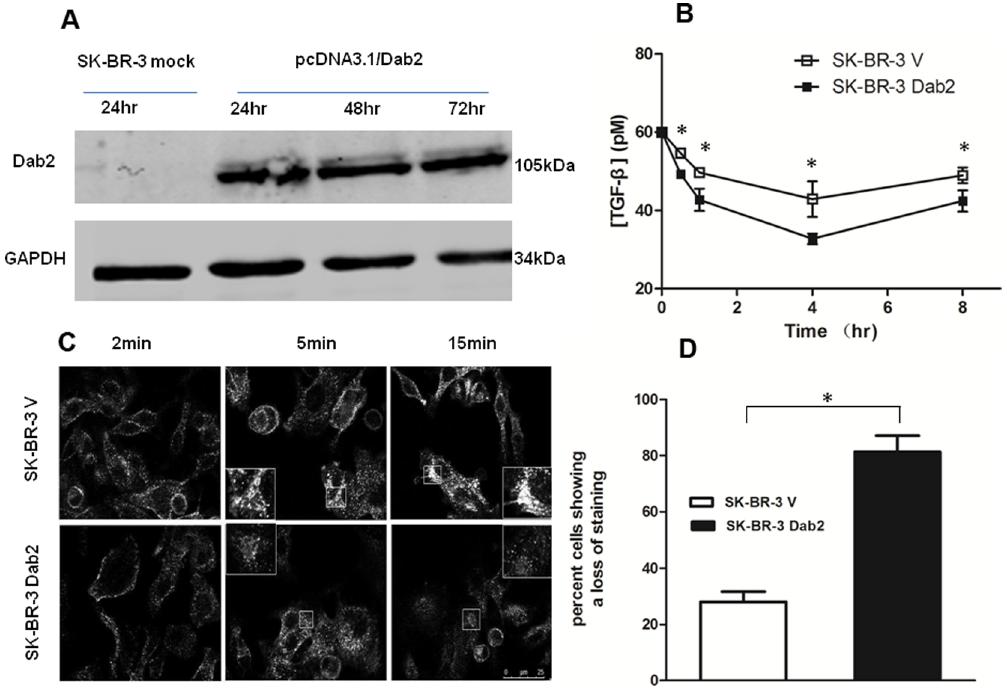
Figure 5. Influence of Dab2 expression on TGF- b depletion in SK-BR-3 cells. (A) Western blot analysis depicting Dab2 expression in SK-BR-3 cells after transfection with pcDNA3.1/Dab2. (B) TGF- b depletion by mock- and Dab2-transfected SK-BR-3 cells were measured with the reporter assay. Re-installation of Dab2 partially restored TGF- b depletion in the SK-BR-3 Dab2 cells, indicated by significant lower TGF- b content in its condition medium compared with the condition medium of SK-BR-3 V cells. (C) Influence of Dab2 on recycling of Tfn in breast cancer SK-BR-3 cells. Bar, 25 um. (D) After endocytosis, Tfn accumulates in the cytoplasm around the nucleus. The proportion of cells that showed diffued staining(indicative of Tfn recycling) within 15 min, out of a total of 50 cells examined, was calculated. *P ,